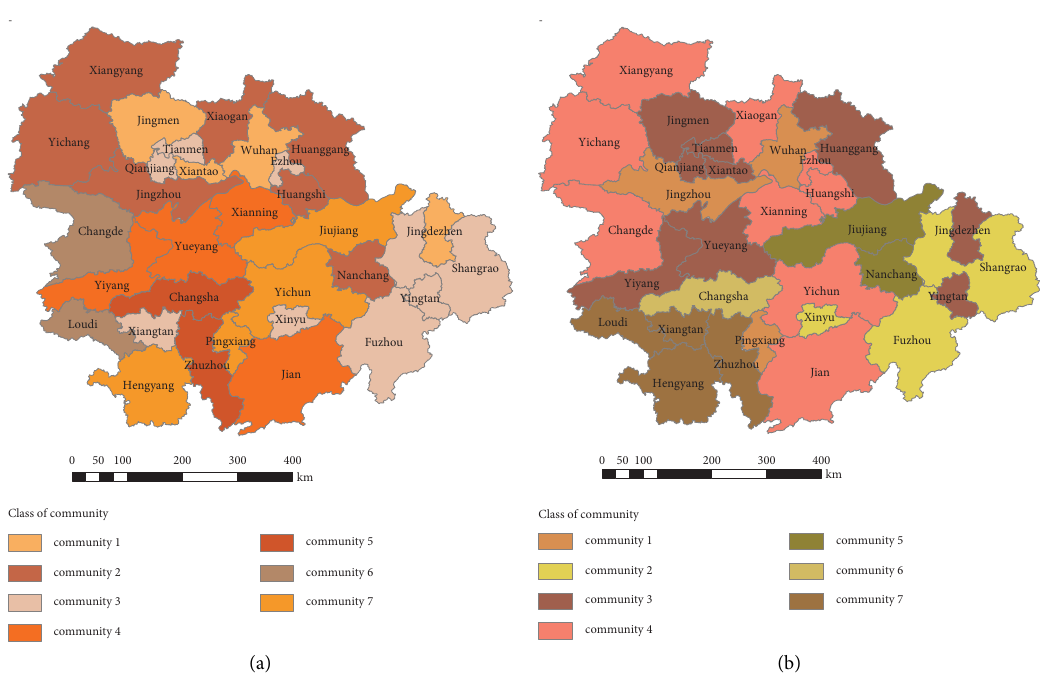
Figure 4: Composition of freight network communities in urban agglomerations in the middle reaches of the Yangtze river in 2014 (a) and 2018